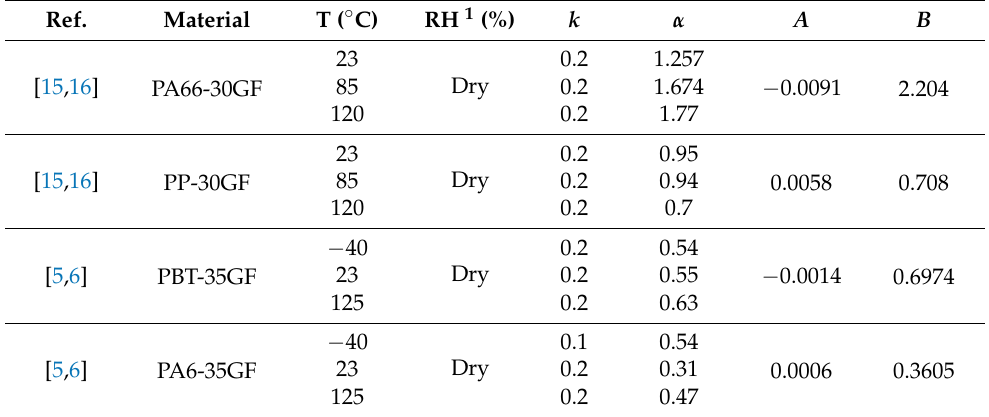
Table 3. FS and general model constants for considered materials under different environmental